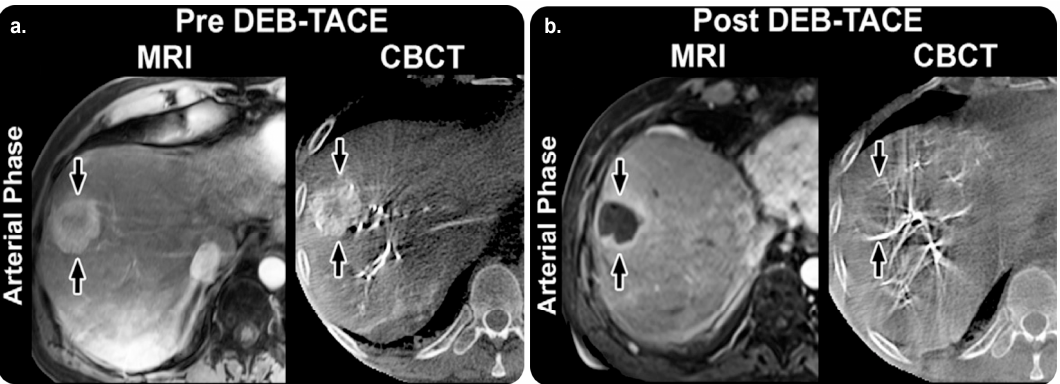
Figure 2. SmartCT software soft tissue technique and its role in management planning. ( a ) Arterial- phase images obtained before TACE. MRI revealing a 75 mm mass in the right lobe “arrow” with 65% enhancement. The mass has a similar enhancement (75%) with CBCT. ( b ) Arterial-phase images obtained after TACE. Mass shows almost no enhancement (5%) with MRI, and the tumor is decreased to 69 mm. With CBCT, the intraprocedural mass enhancement is decreased by 87%, which allows prediction of an objective EASL response at 1 month. Abbreviations: TACE, transarterial chemoembolization; MRI, magnetic resonance imaging; CBCT, cone-beam computed tomography; EASL, European Association for the Study of the Liver. Reprinted from “Intraprocedural C-arm dual-phase cone-beam CT: Can it be used to predict short-term response to TACE with drug-eluting beads in patients with hepatocellular carcinoma?” by Loffroy et al. [14] with written approval from the corresponding author and publisher (Radiology; Copyright 2013).